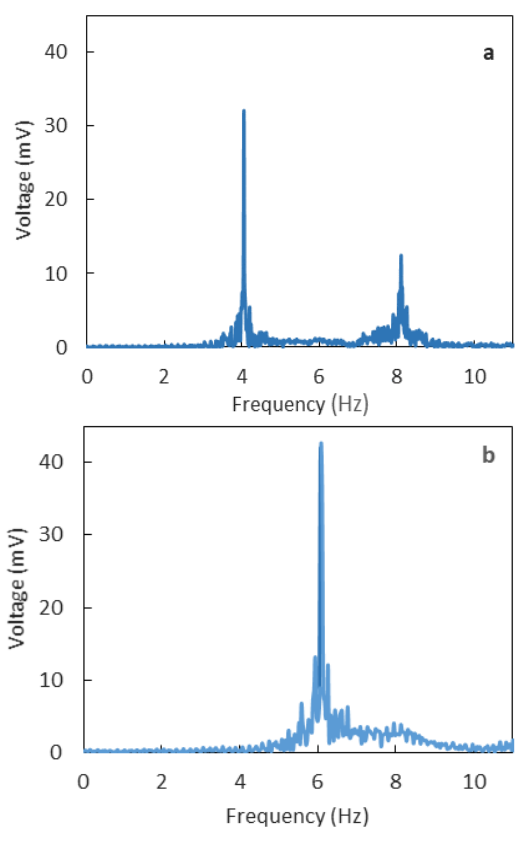
Figure 4. Results of FFT analysis a. 4 Hz, b. 6